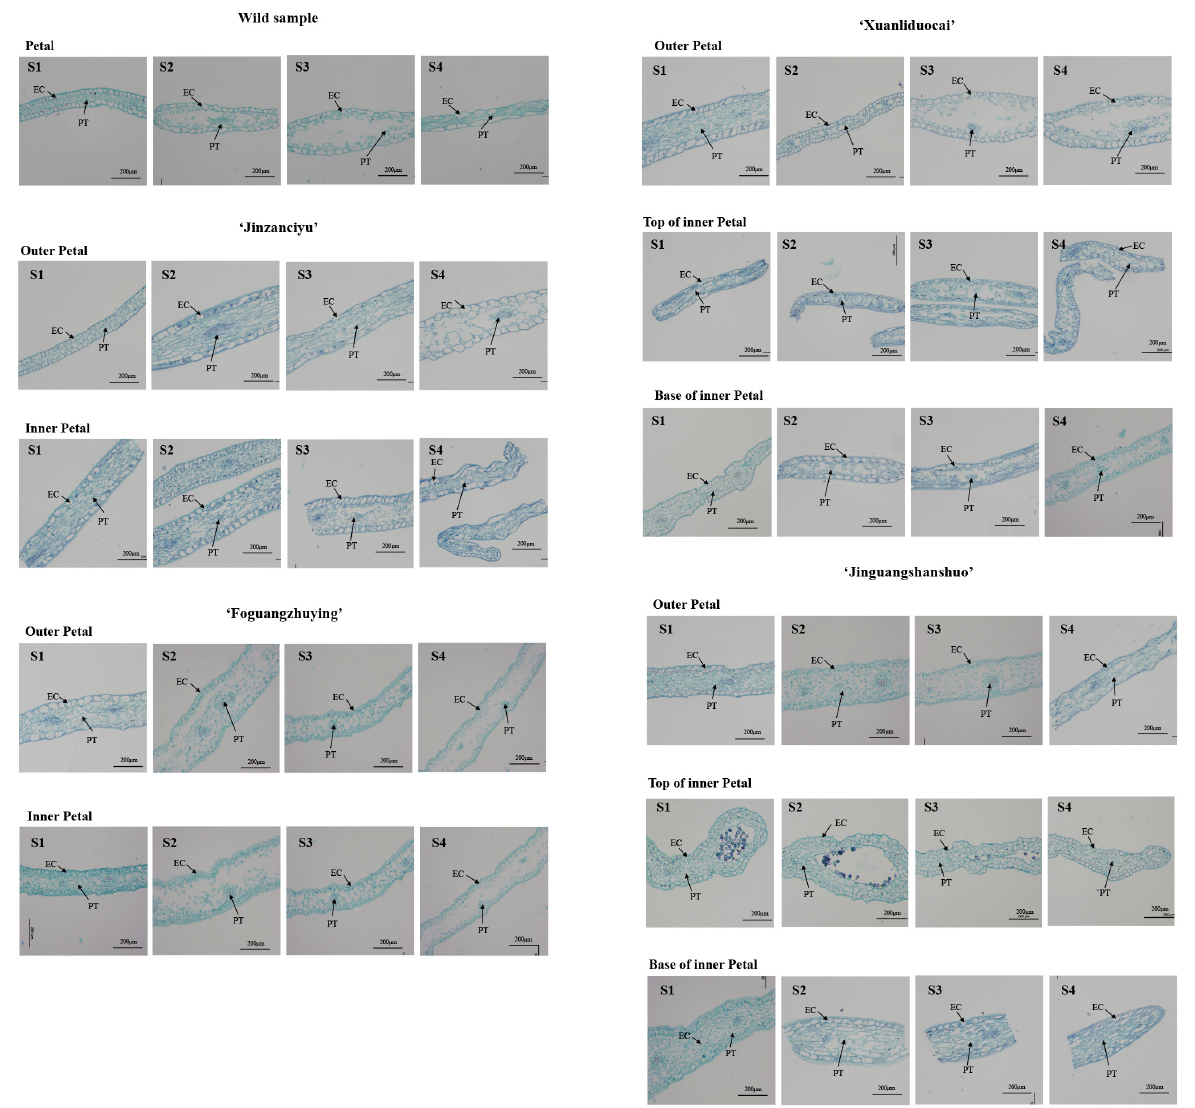
Figure 3. Changes in petal microstructure in different flowering stages of the herbaceous peony. Abbreviations: S1, bud stage; S2, opening stage; S3, blooming stage; S4, decay stage; EC, epidermal cells; PT, parenchyma. Table 4. Physical parameters of herbaceous peony petals.